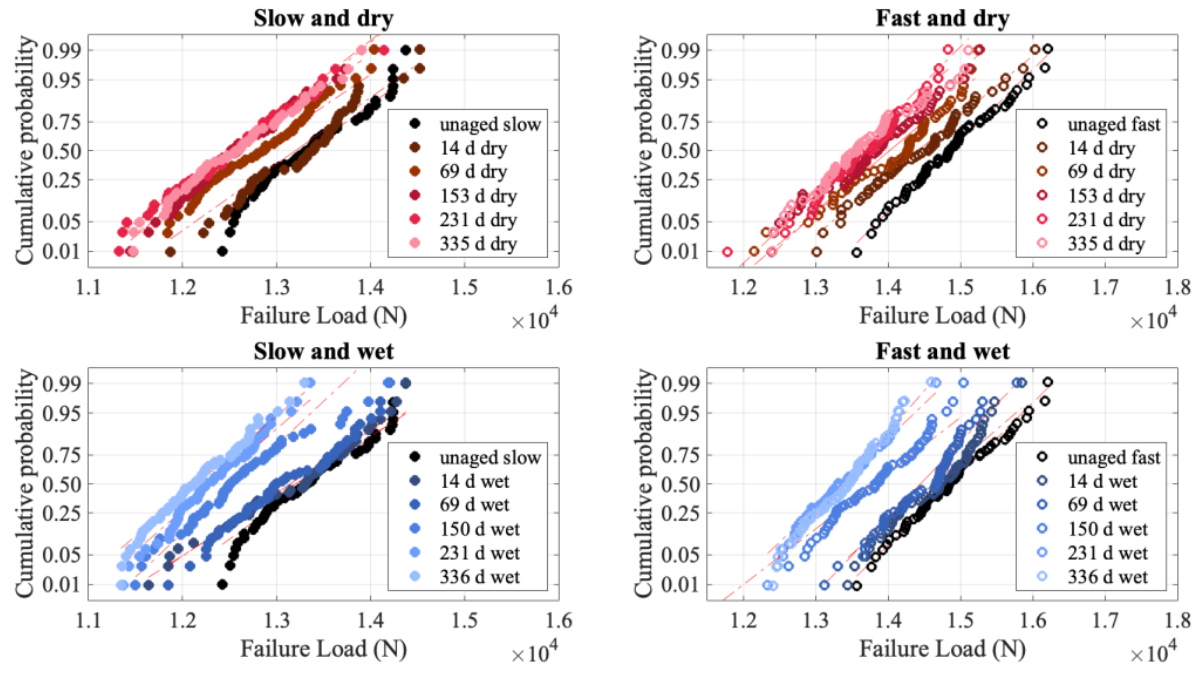
Figure 6. Normal probability plots for failure load. Figure 6 is plotted as a normal probability plot because the failure distributions